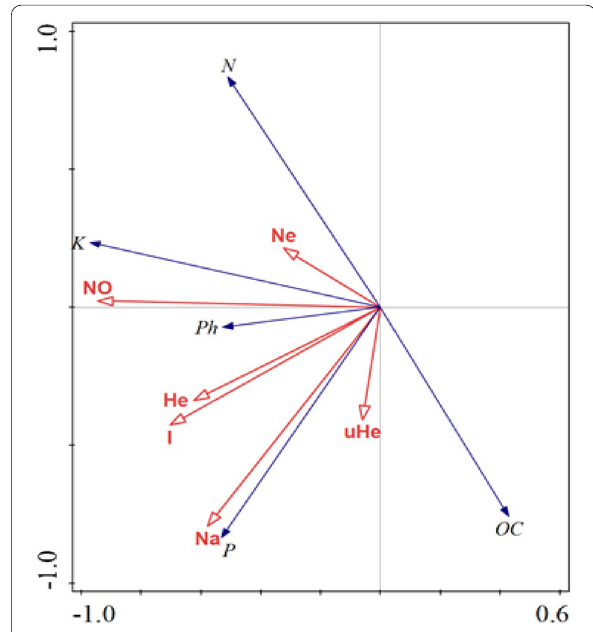
Fig. 7 Canonical correspondence analysis (CCA) biplot analysis of bradyrhizobia isolates with soil physicochemical properties. OC, organic carbon; Ph, pH; K, potassium; P, available phosphorus; N, Total nitrogen; No, number of isolates; Na, number of alleles; Ne, number of effective alleles; I, information index; uHe, unbiased expected